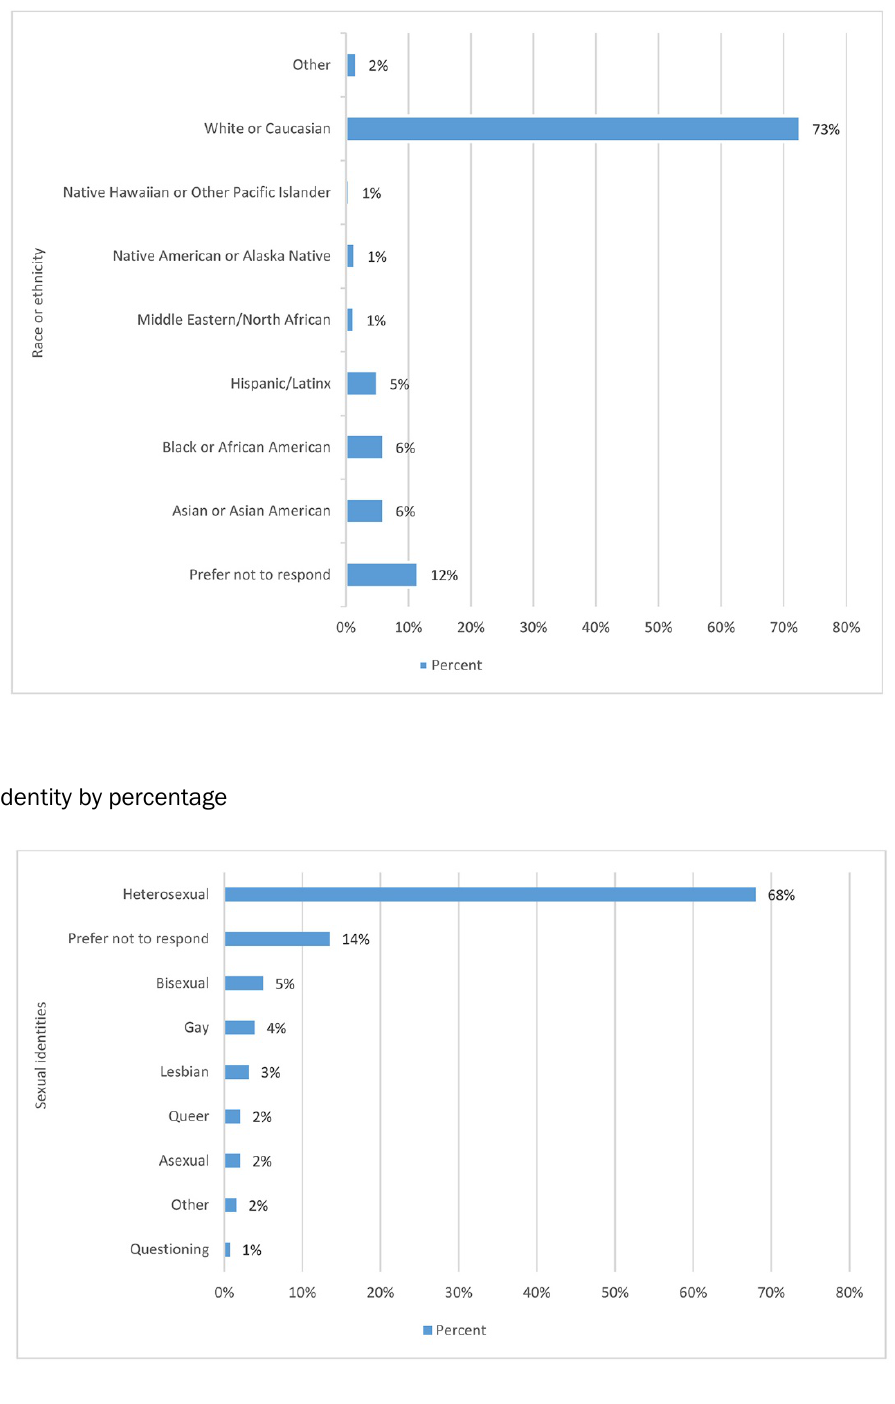
Figure 3 Race/ethnicity by percentage